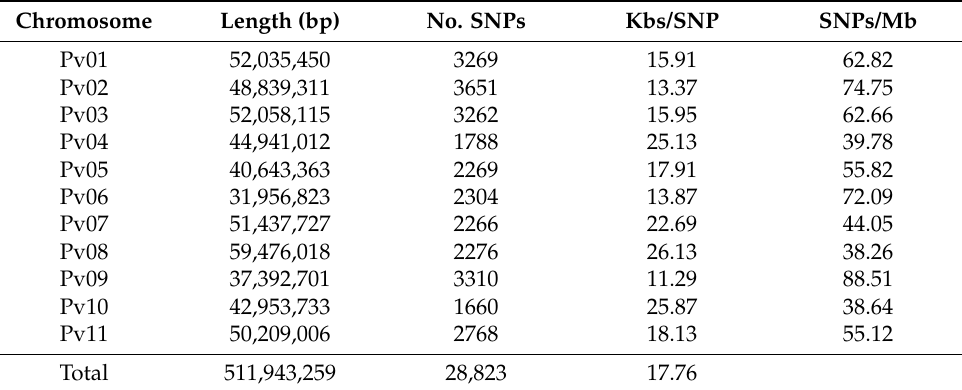
Table 1. Number of SNPs, the beginning, and the end in Mb for the 11 chromosomes of common bean accessions in Brazil.